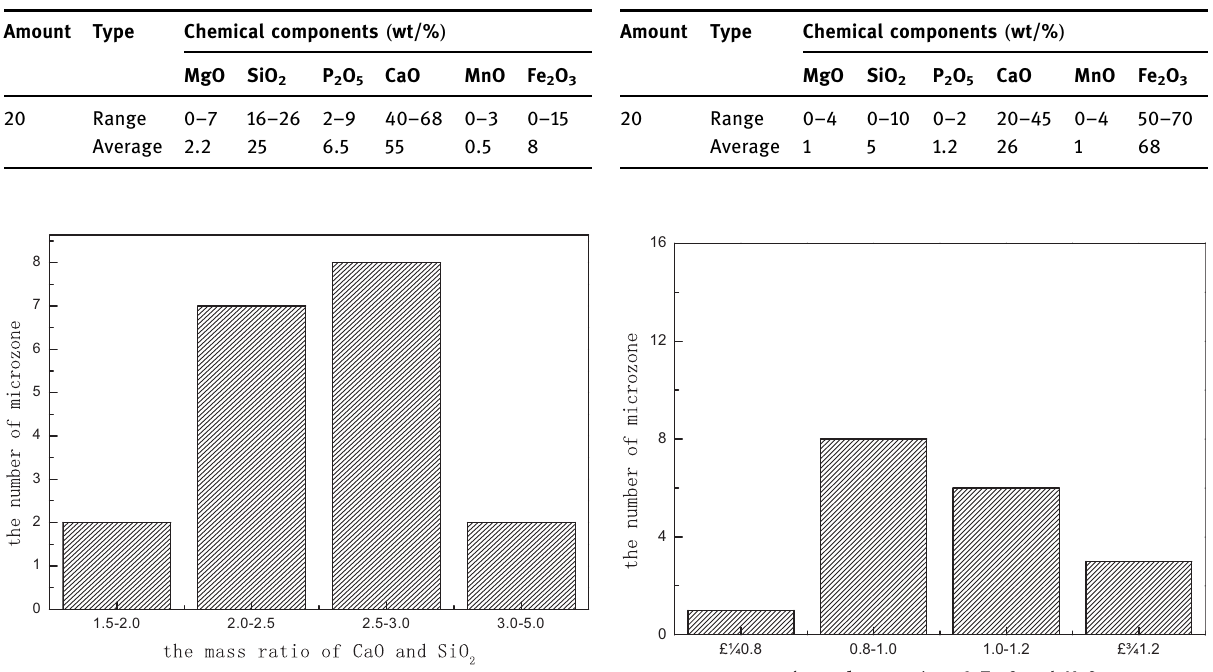
Figure 9: The basicity distribution in phase A.